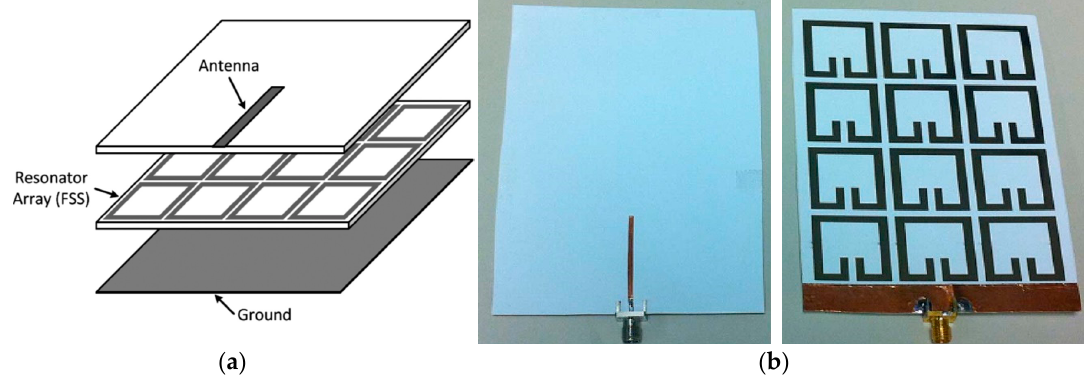
Figure 17. Inkjet-printed monopole antenna on the artificial magnetic conductor (AMC) plane: ( a ) Structure and ( b ) fabricated antenna.